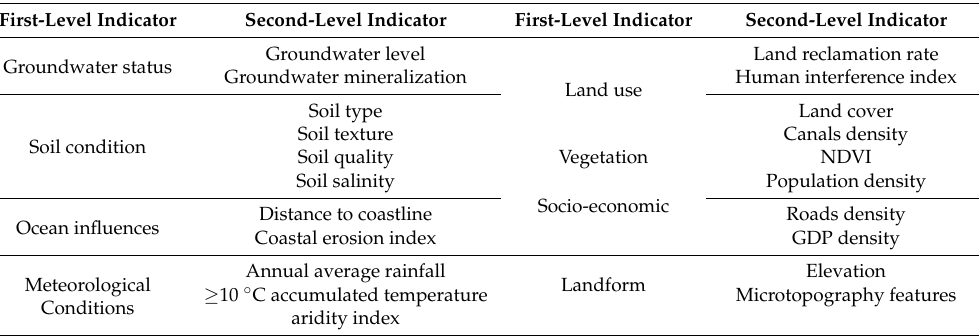
Table 1. Two levels of indicators selected for ecological vulnerability